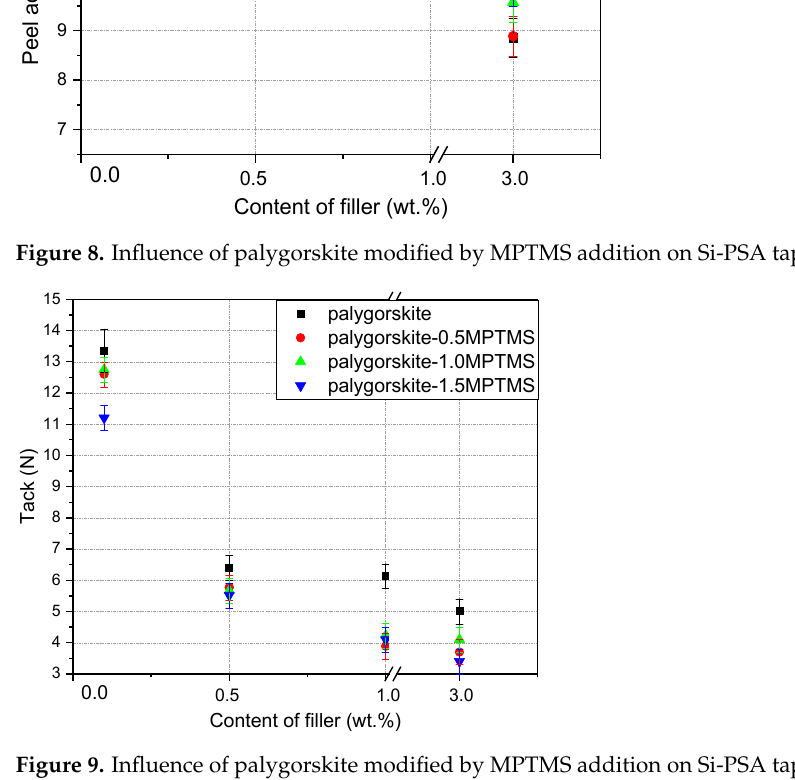
Figure 8. Influence of palygorskite modified by MPTMS addition on Si-PSA tape adhesion.